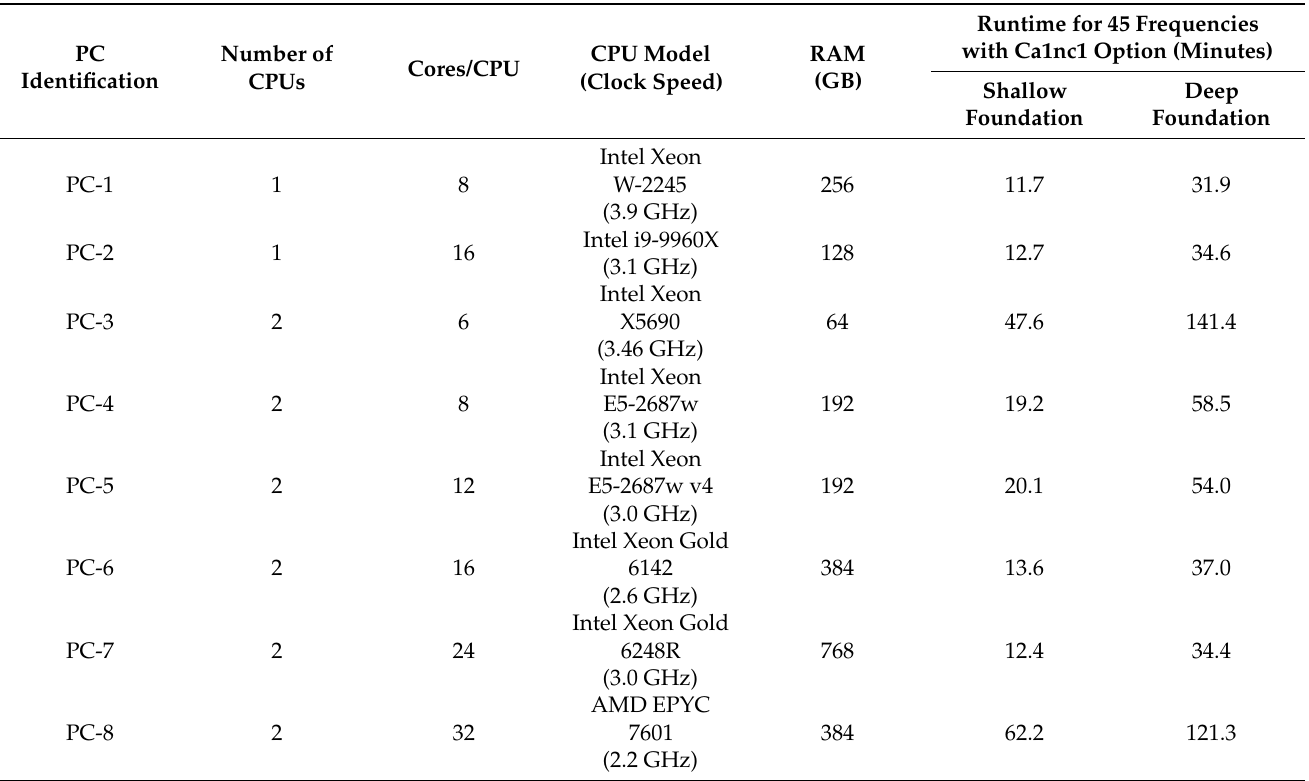
Table 2. Specifications of the computer systems used in this